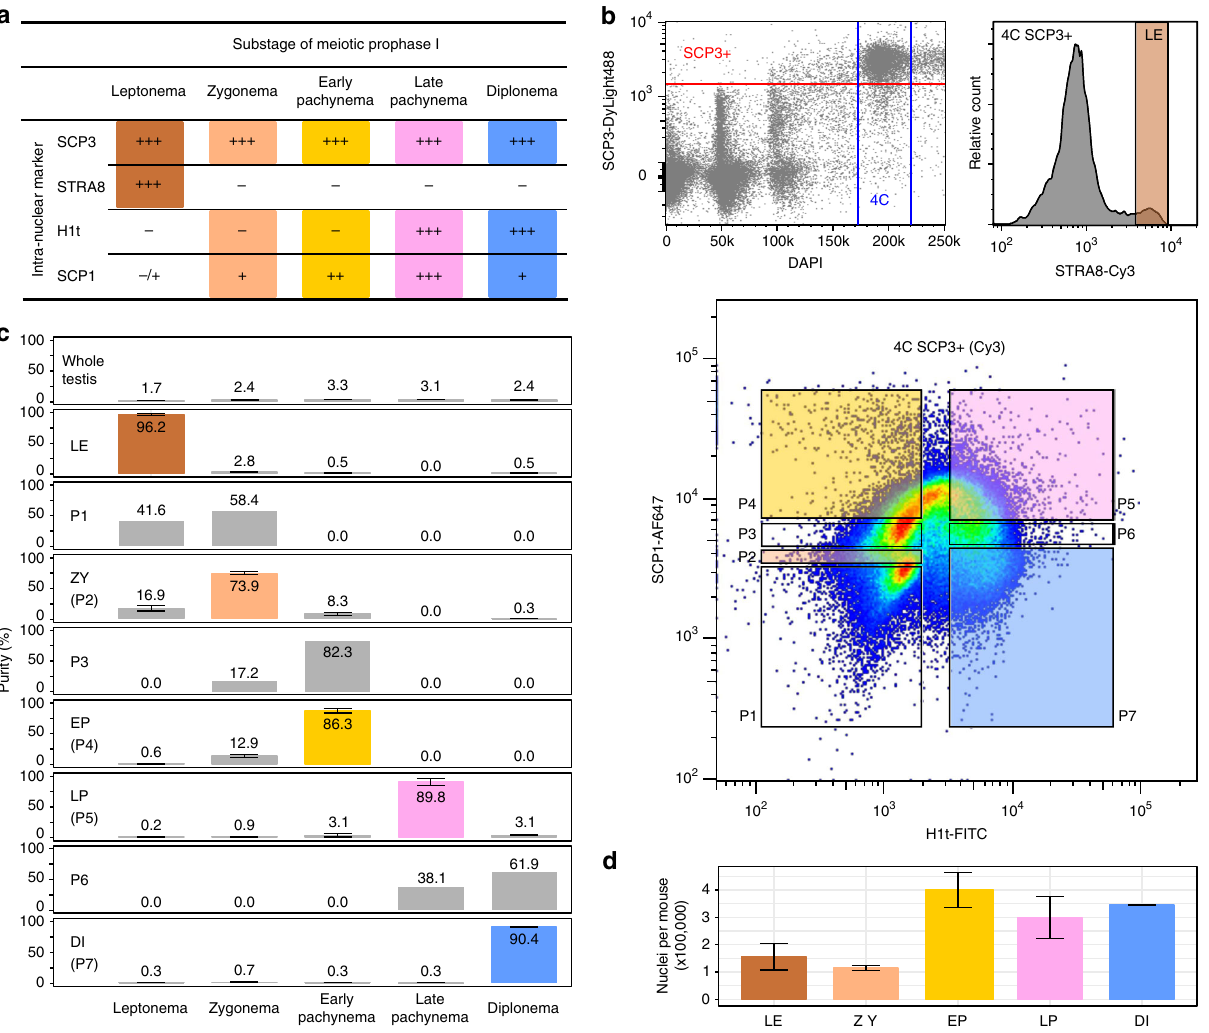
Fig. 2 Experimental design for isolating stage-speci fi c spermatocyte nuclei. a Signal strength of intra-nuclear markers across meiotic substages observed in immuno fl uorescence staining. Signal strength is classi fi ed as absent ( − ), very weak ( − / + ), weak ( + ), medium ( ++ ), or strong ( +++ ). Combinatorial markers for isolating stage-speci fi c nuclei are highlighted. b Flow cytometric strategies for isolating populations of stage-speci fi c nuclei. Meiotic 4C nuclei are gated by DAPI and SCP3 signals (top left). Stage-speci fi c nuclei are sorted into populations based on combinatorial signals of intra-nuclear markers in two separate sorts; one using antibodies against STRA8 for leptonema (top right), and the other one using antibodies against H1t and SCP1 for seven populations (P1 to P7) (bottom). c Distributions and purities of each speci fi c type of nuclei in whole-testis and in sorted populations. The fi ve selected populations of leptonema, zygonema, early pachynema, late pachynema, and diplonema are highlighted as LE, ZY, EP, LP, and DI, respectively. Purities (mean with standard error) of these populations are derived from two or three independent sorts. d Numbers of nuclei in each subpopulation collected in an adult mouse. Data (mean with standard error) are derived from two independent sorts. Source data are provided as a Source Data fi